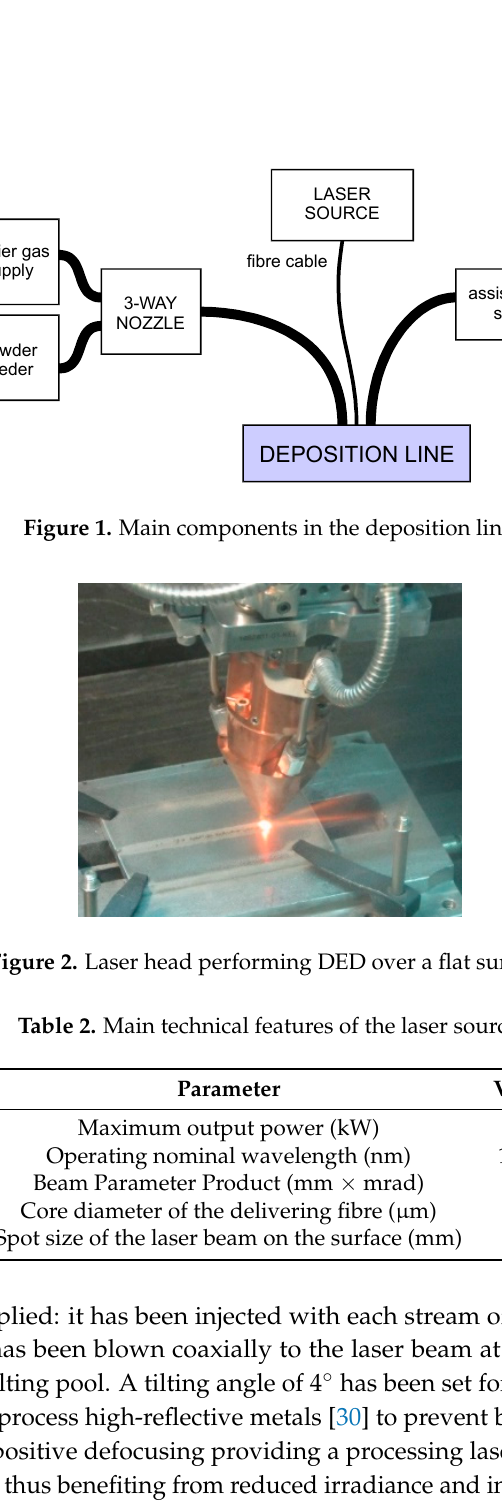
Table 1. Nominal chemical (wt.%) composition of base and fed metals.